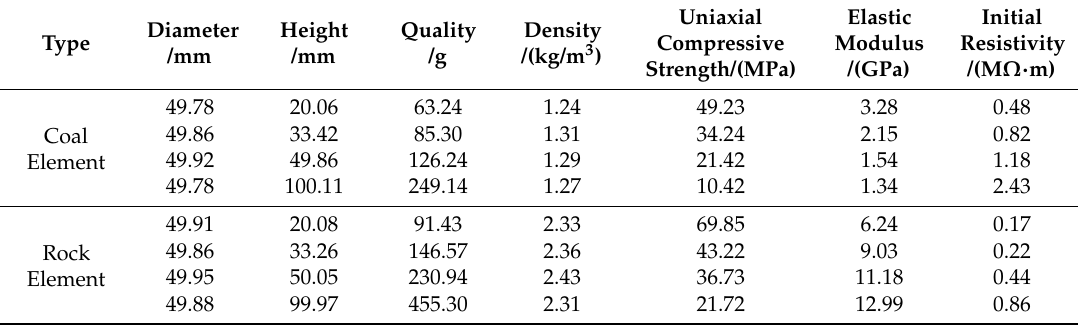
Table 1. Physical and mechanical parameters of experimental coal and rock elements.